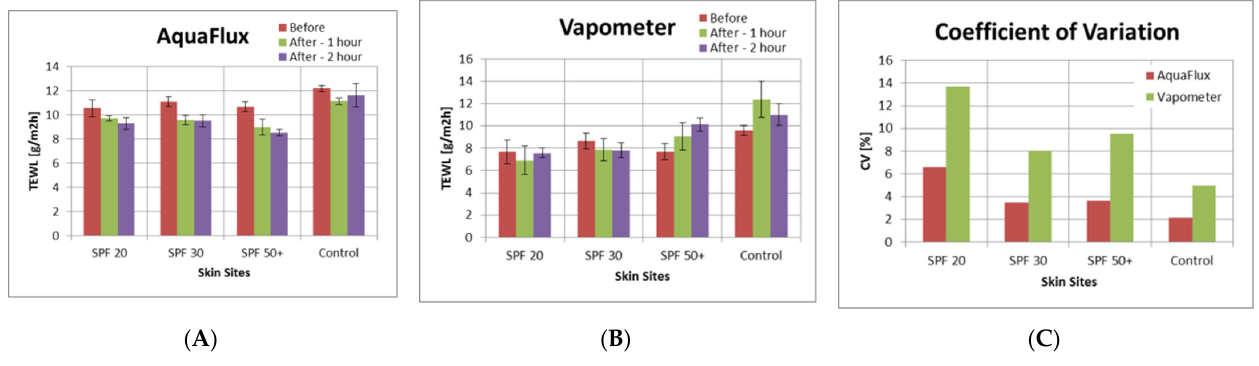
Figure 3. The TEWL values of four volar forearm skin sites before and after the sun tan lotion application, measured by AquaFlux ( A ) and VapoMeter ( B ), and their coefficient of variation ( C ). Figure 4 shows the corresponding TEWL value changes before, 1 h after, and 2 h after the sunscreen application, measured with the AquaFlux and VapoMeter. The AquaFlux results show that the TEWL values decreased 1 h after the sunscreen application, and continued to decrease 2 h after. This was the same for sunscreens with SPF 20, SPF 30, and SPF 50+. Of interest is the proportional decrease in TEWL with SPF number, with SPF 20 having the smallest TEWL decrease and SPF 50+ the largest. The control site had a small change with time. The VapoMeter results, however, did not show any consistent trend.